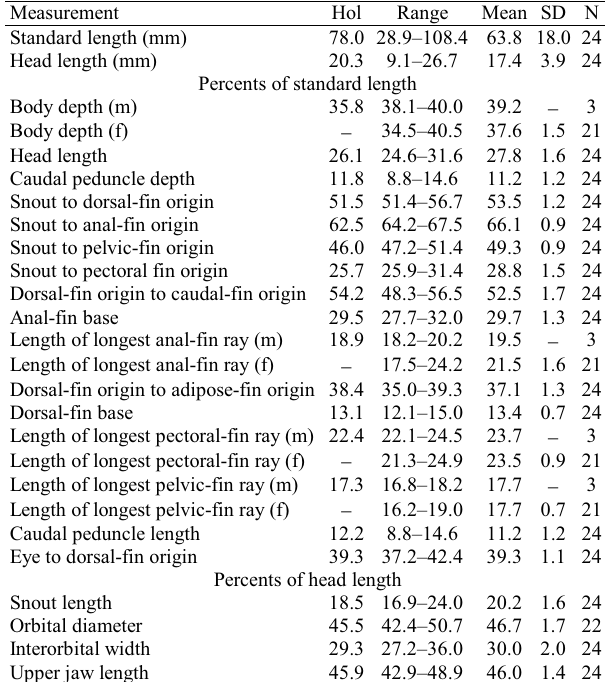
Table 1 . Morphometric data for Astyanax henseli . Measure- ments based on the holotype ZMB 7479, and non types speci- mens MNRJ 14186, MNRJ 22174, MNRJ 22214, and MNRJ 22231. (Hol, holotype; m, males; f, females). Measurement